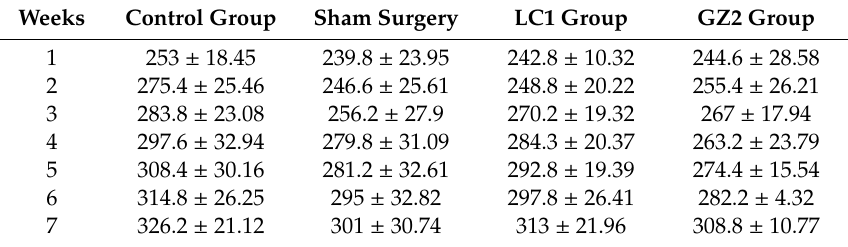
Table 2. Post-surgery evolution of the body weight gain.